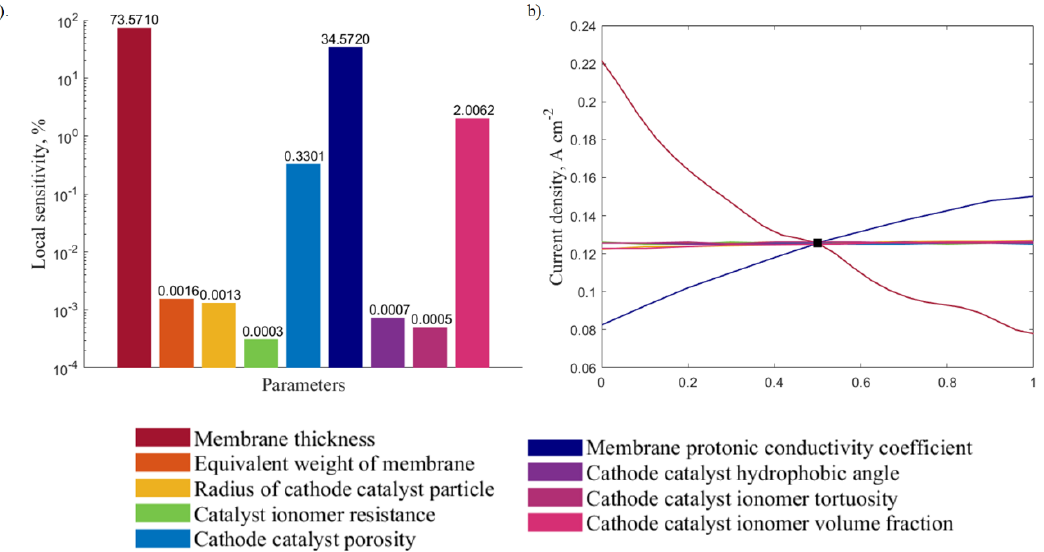
Figure 7. Local sensitivity analysis at 0.6 V presented in: ( a ) bar plot and ( b ) sensitivity curve.